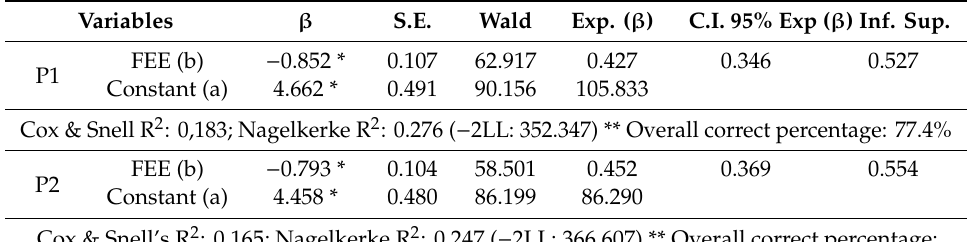
Table 16. Logistic regression results for WTPEF in the HNP case.